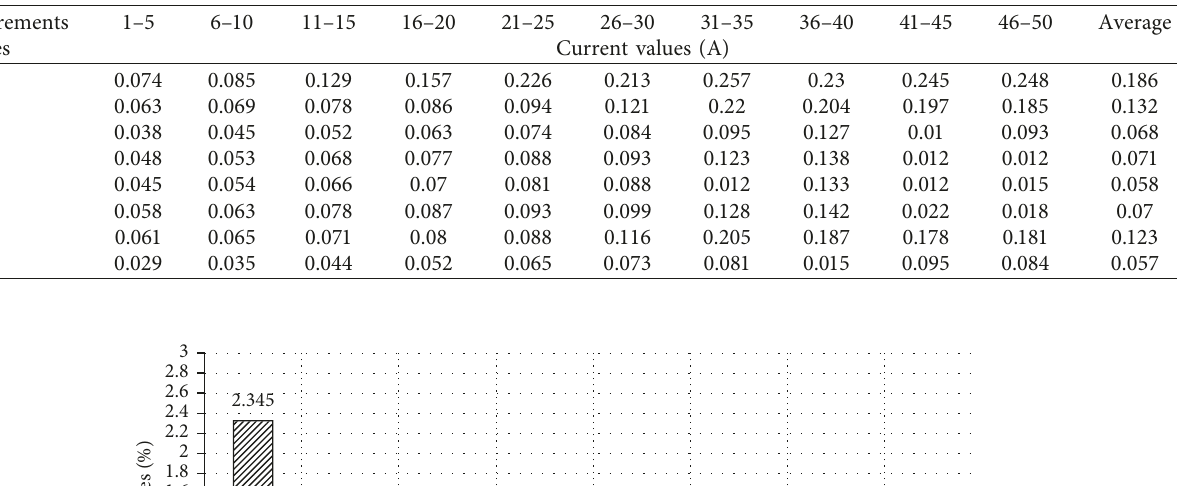
Figure 3: Potential difference values obtained from the galvanic cell Table 6: Current measurements in the samples.